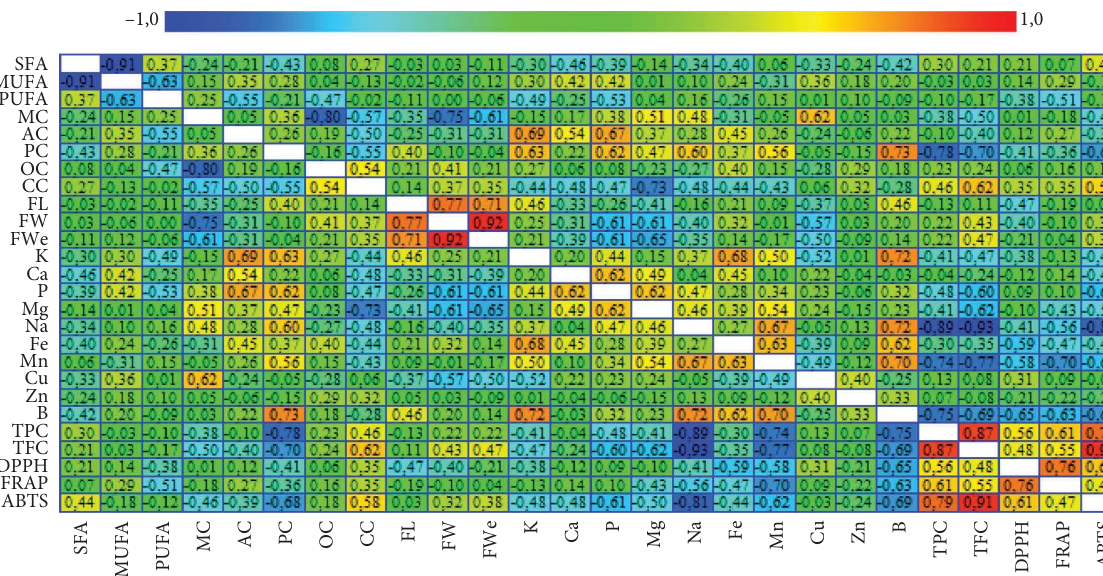
Figure 4: Coefcients of correlations (Pearson correlation) among studied dependent variables. FWe � weight, FL � fruit length, KW � fruit width, OC � oil content, CC � carbohydrates content, PC � protein content, AC � ash content, and MC � moisture content. SFA � saturated fatty acids, MUFA � monounsaturated fatty acids, and PUFA � polyunsaturated fatty